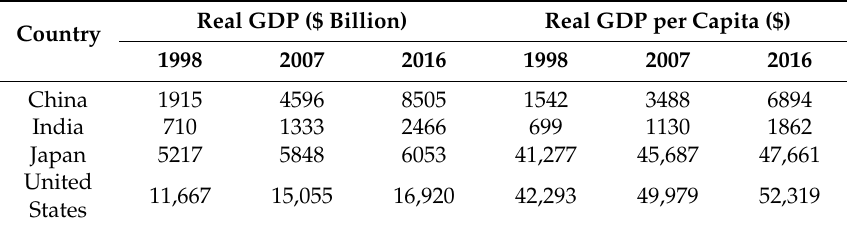
Table 1. Real GDP and real GDP per capita in selected